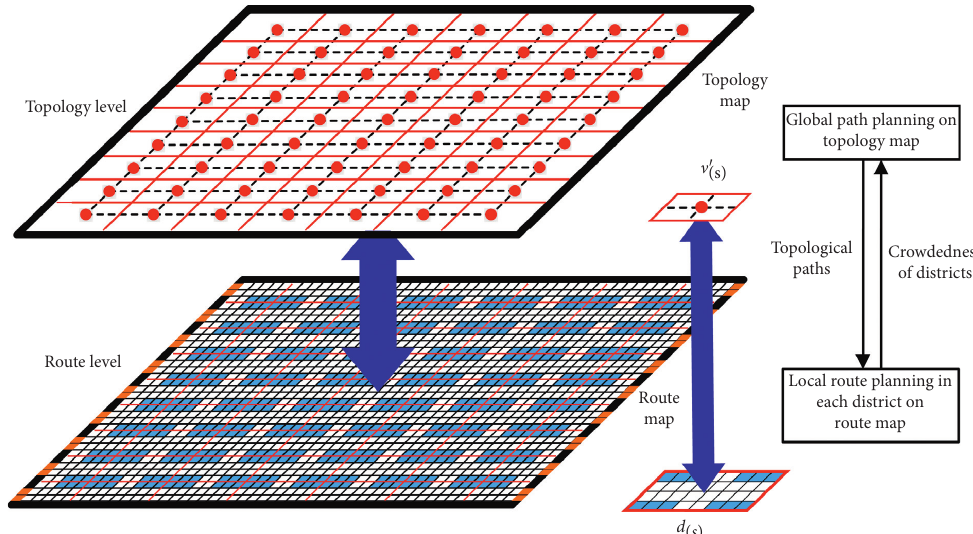
Figure 3: The bi-level architecture of the